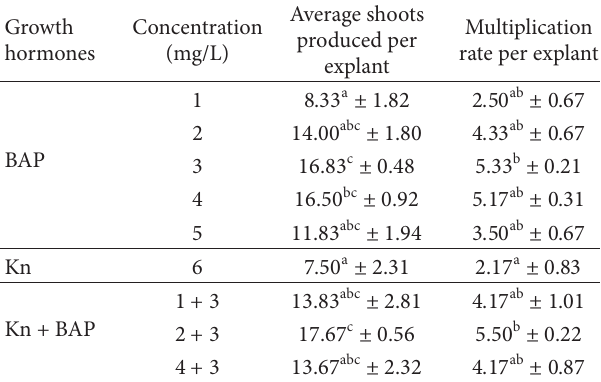
Table 1: Effect of BAP, Kn, and Kn + BAP in MS medium on shoot multiplication of Bambusa tulda